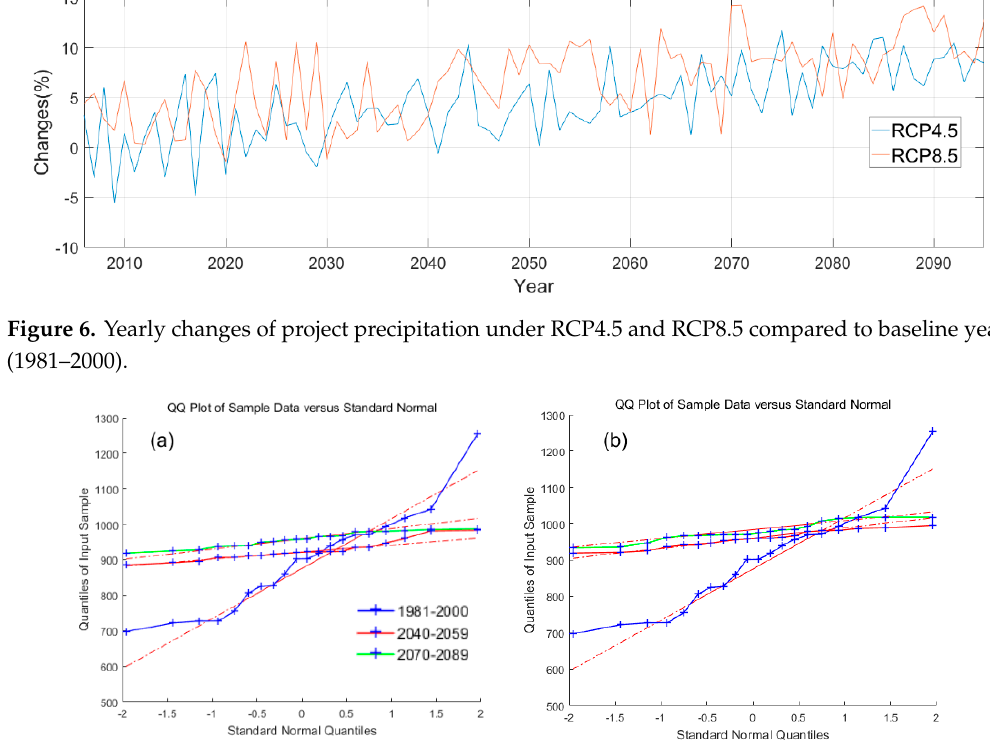
Figure 7. Quantile–quantile plots of annual historic and projected precipitation under: ( a ) RCP4.5; ( b ) RCP8.5, respectively.